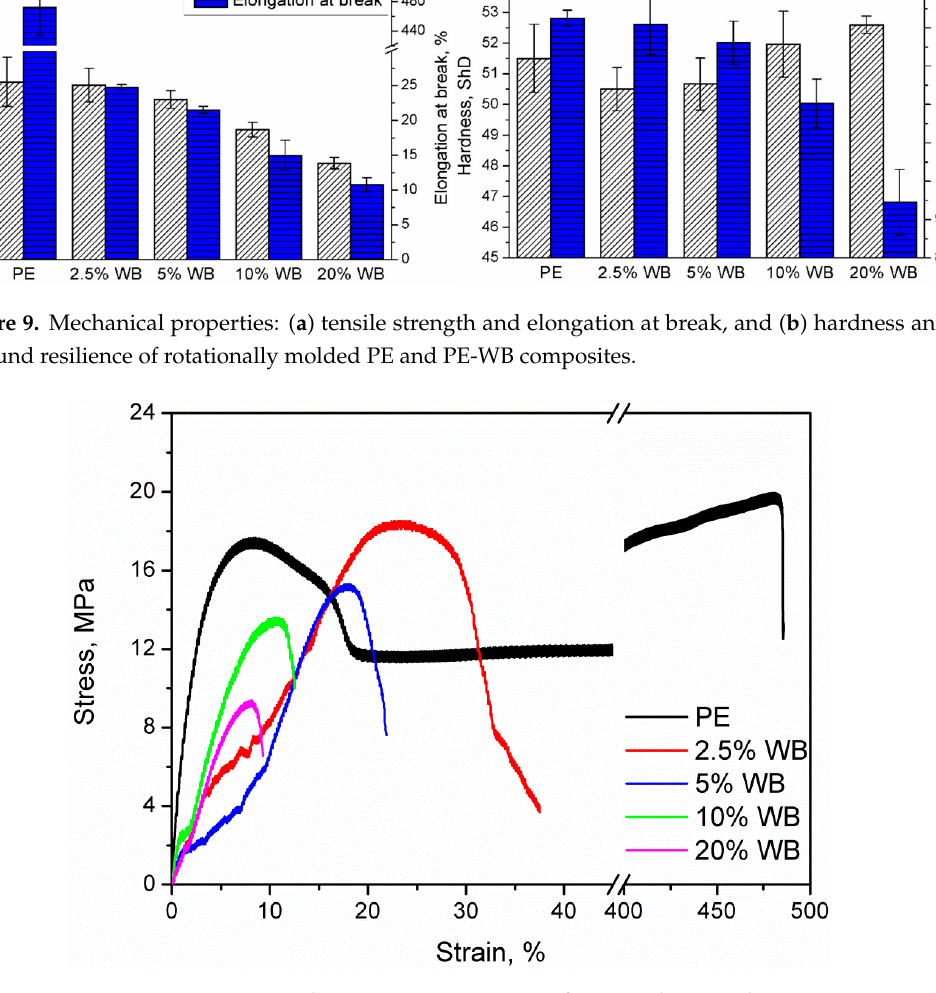
Figure 11. The impact of ( a ) porosity and ( b ) adhesion factor on the tensile strength and rebound resilience of the rotationally molded samples. 3.4. Rheological Behavior According to Chaudhary et al. [44], the increased melt viscosity of rotationally molded material at low shear rates as well at zero shear viscosity is connected with extending the sintering process and difficult bubble removal during rotational molding. Therefore, the realization of detailed studies using oscillatory rheometrical analysis at low angular frequencies became essential to understand the changes in final product structure and resulting properties changes. Figure 12 shows storage (G’) and loss (G”) modulus changes as a function of strain obtained during strain sweep experiments. Incorporation of lignocellulosic filler caused the increase of both moduli as well as shortening of the linear viscoelastic region. Nevertheless, the increase of modulus was not so substantial, as for the incorporation of wood flour, which can be associated with the enhanced flowability of material due to protein content in wheat bran [16]. While for the pure and composite samples containing up to 2.5 wt.% of the filler LVE range was comparable, further increasing content of the WB caused the effect